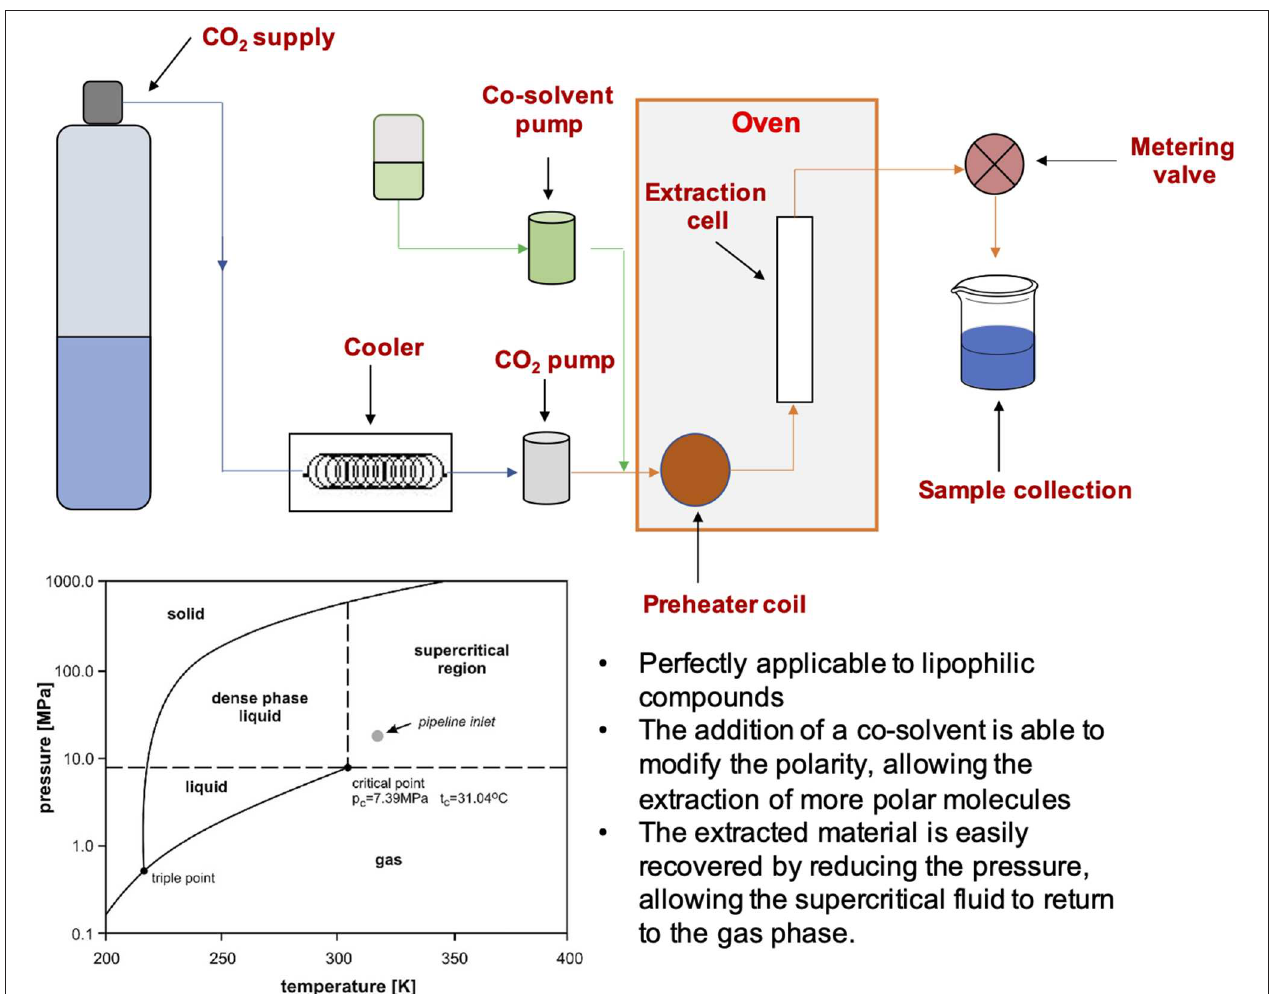
FIGURE 5 | Schematic representation of SFE equipment and